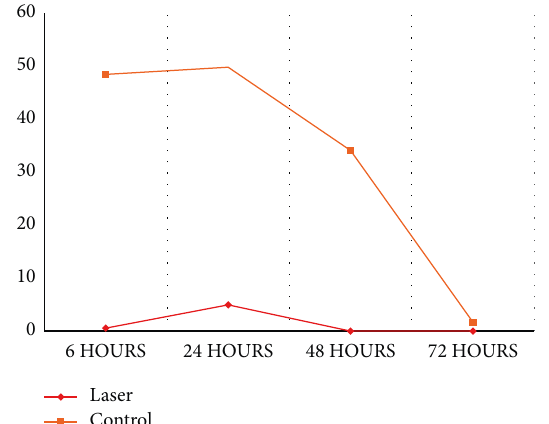
Figure 2: Level of painful symptoms in VAS score (mm) with time.